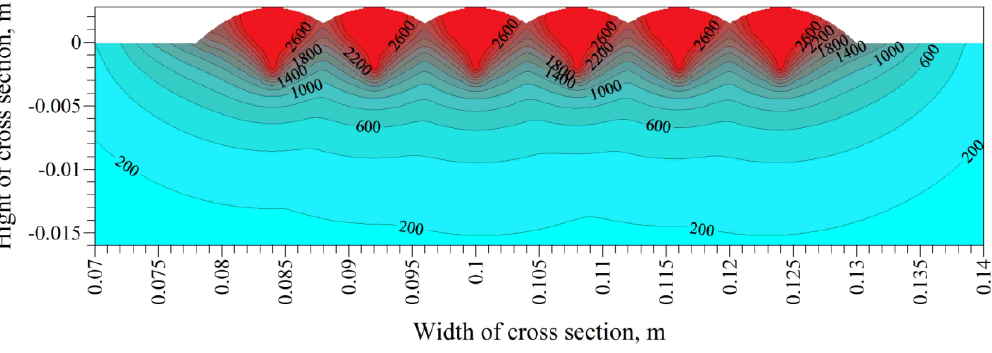
Figure 19. Maximum temperatures ( ◦ C) in the middle part area of cross-section during surfacing with alternate sequence of the weld padding.